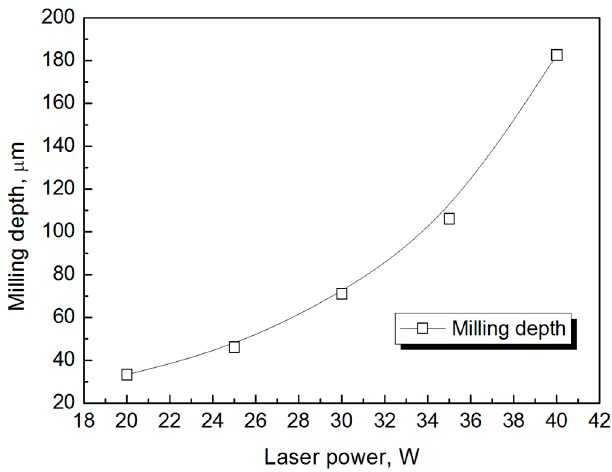
Figure 5. Milling depth at different laser powers.